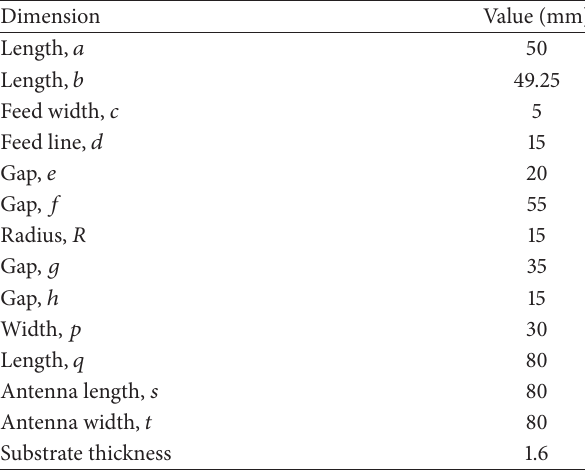
Table 2: Design parameters of the proposed antenna. Dimension Value (mm) Length, 𝑎 50 Length, 𝑏 49.25 Feed width, 𝑐 5